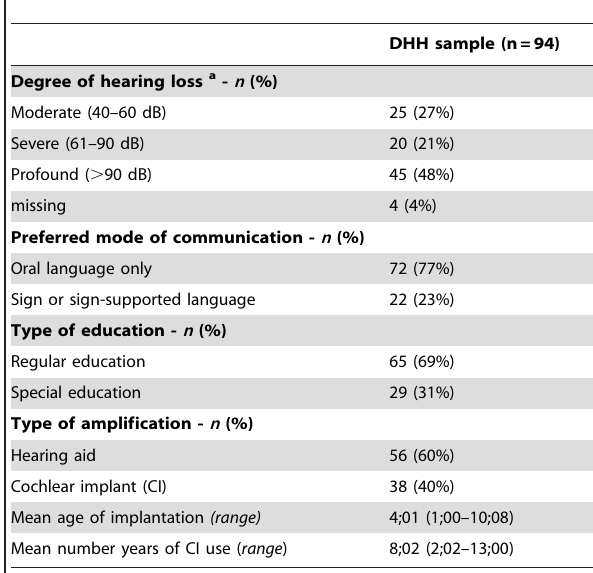
Table 2. Characteristics specific for the DHH